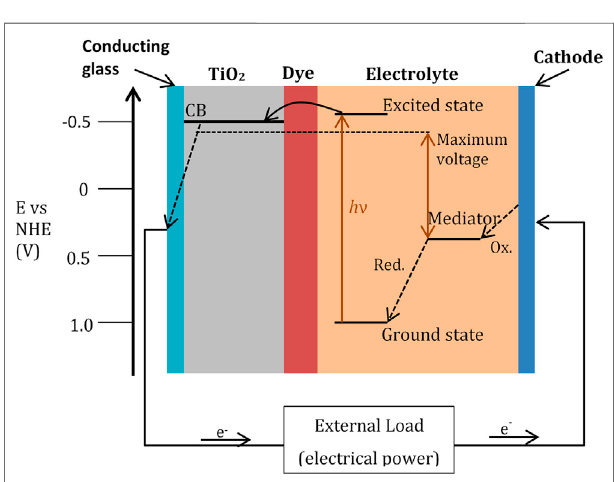
FIGURE 5 | Schematic representation of the operation principle for a typical dye-sensitised nanocrystalline solar cell. Photoexcitation of the sensitiser from the ground state to the excited state is followed by electron injection into the conduction band (CB) of a semiconductor oxide fi lm. The dye molecule is regenerated by the redox system, which itself is regenerated at the counter electrode by electrons passing through the load. Potentials are referred to as the normal hydrogen electrode (NHE). Image adapted with permission from Grätzel (2005). Copyright 2005 American Chemical